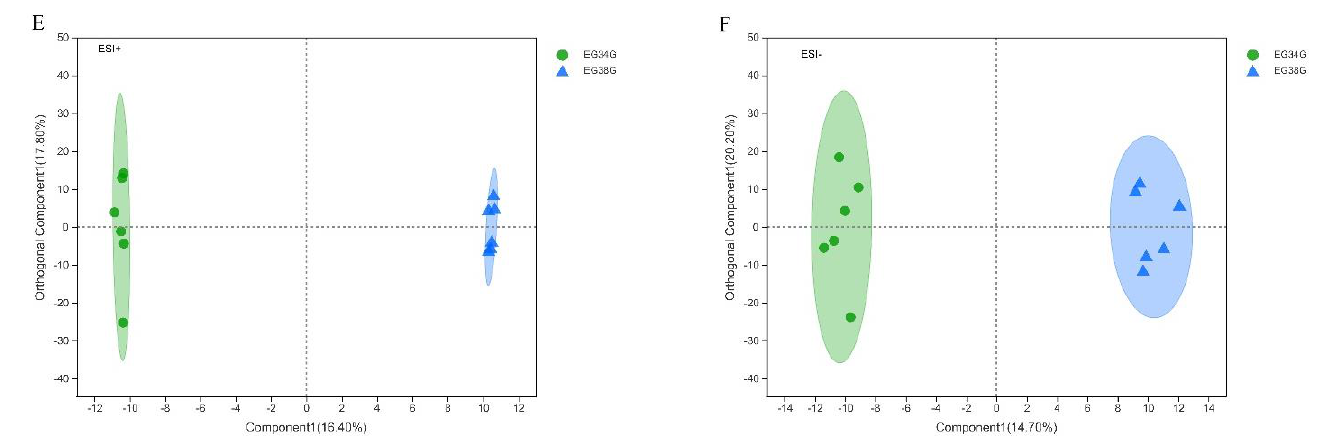
Figure 4. OPLS − DA score scatter plots: ( A ) CG vs. EG34 (ESI+); ( B ) CG vs. EG34 (ESI − ); ( C ) CG vs. EG38 (ESI+); ( D ) CG vs. EG38 (ESI − ); ( E ) EG34 vs. EG38 (ESI+); and ( F ) EG34 vs. EG38 (ESI − ).